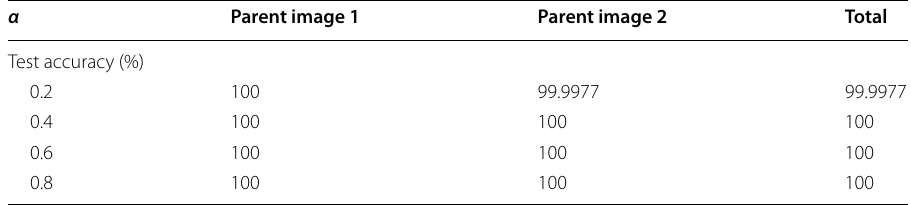
Table 3 MFR‑Net V1 test results for α values α Parent image 1